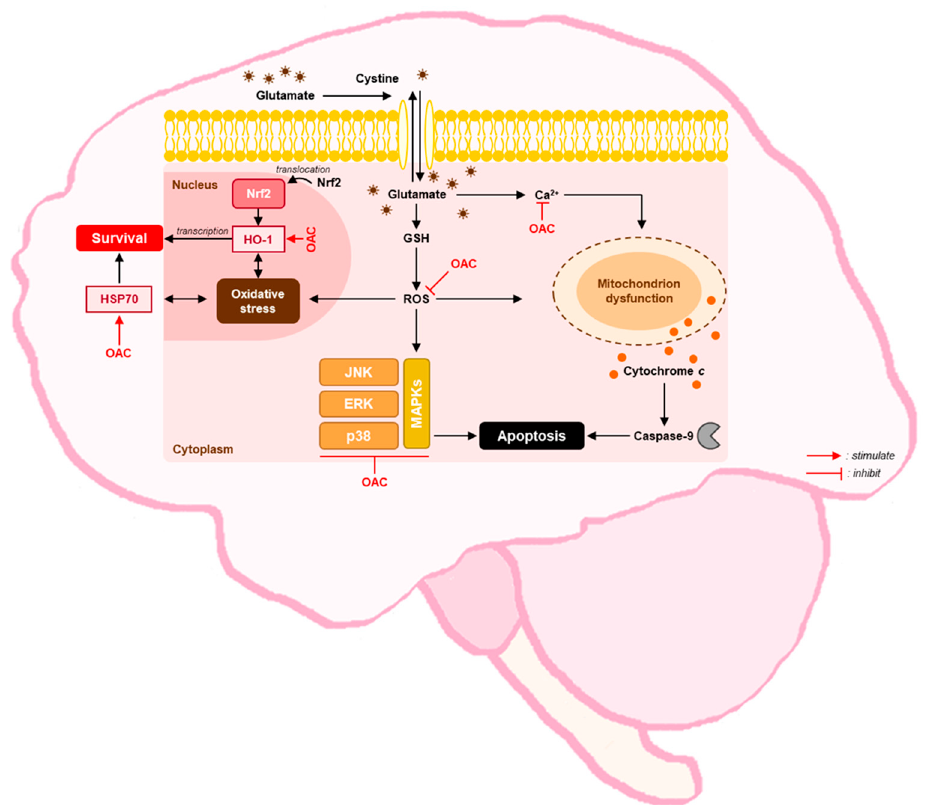
Figure 5. Protective mechanism of OAC against glutamate-induced oxidative stress in HT22 cells. OAC: osmundacetone; Ca 2+ : calcium ion; ERK: extracellular signal-regulated kinase; GSH: glutathione; HO-1: heme oxygenase-1; HSP70: heat shock protein 70; JNK: c-Jun NH2-terminal kinase; MAPKs: mitogen-activated protein kinases; Nrf2: nuclear factor erythroid 2-related factor 2; ROS: reactive oxygen species.